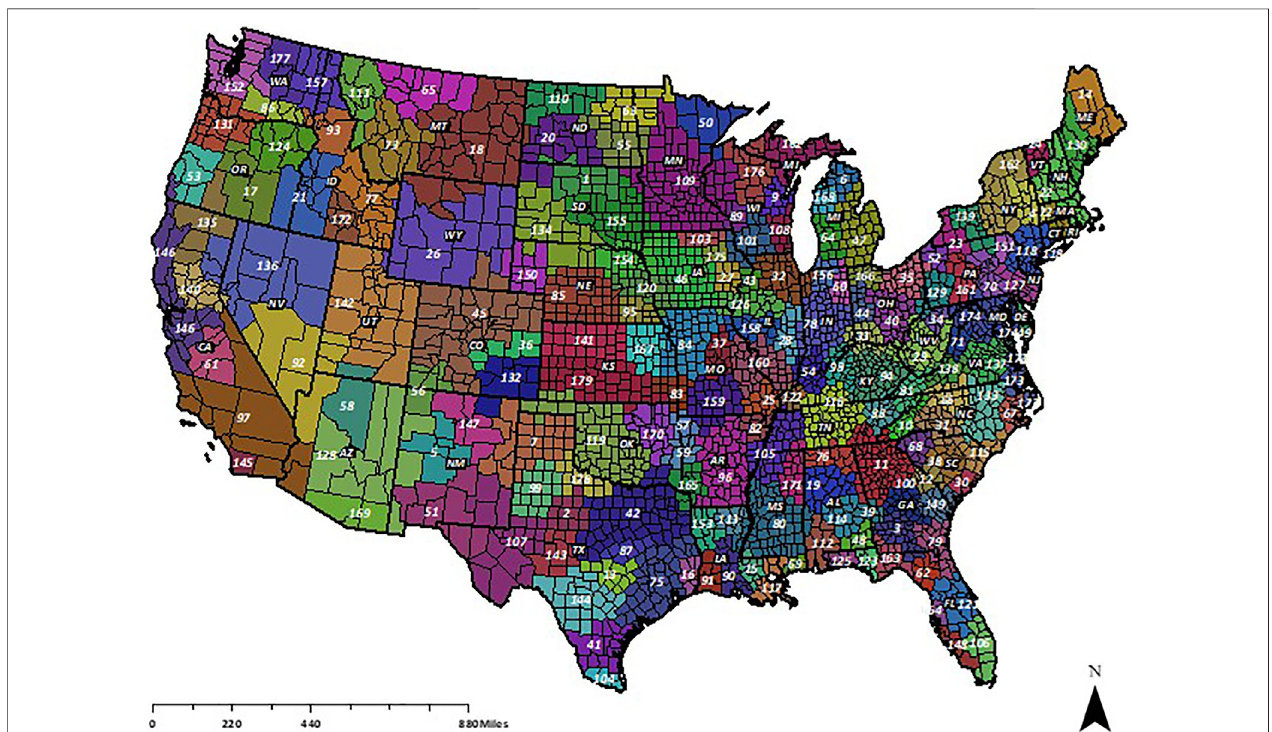
FIGURE 2 | Bureau of Economic Analysis ’ s economic areas for input – output analysis modeling.